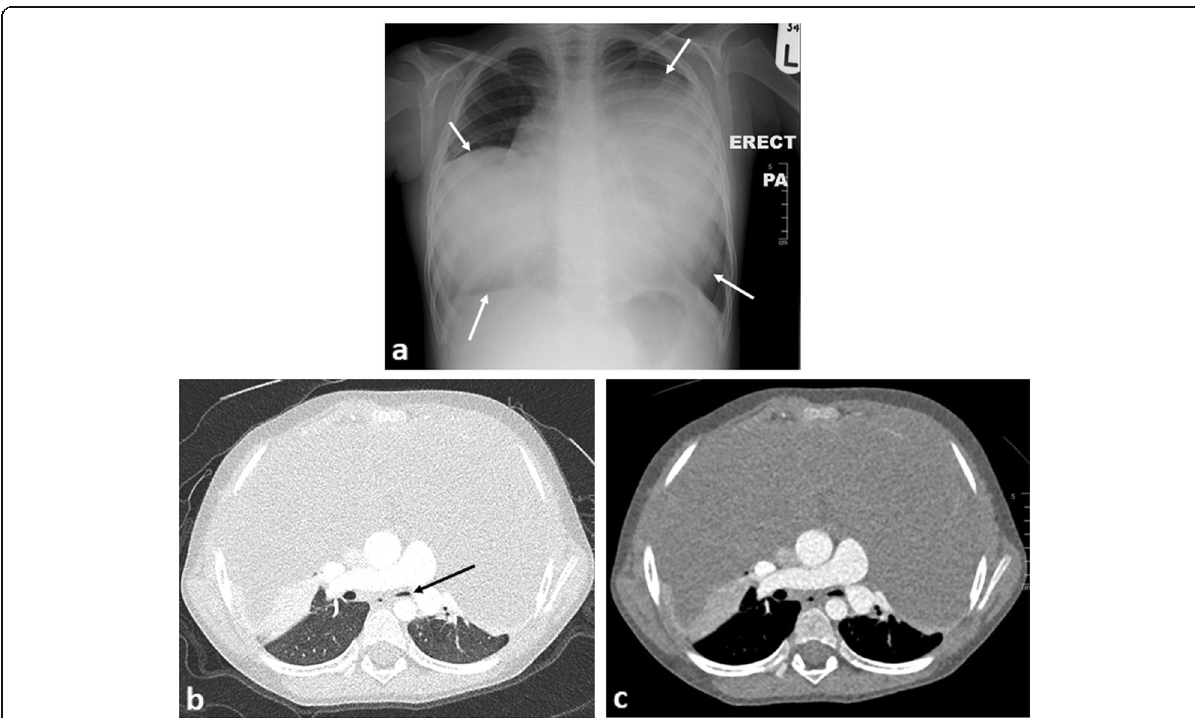
Fig. 8 A 4-year-old boy presenting with shortness of breath secondary to desmoid fibromatosis (a benign, non-cancerous tumour). a The erect chest radiograph demonstrates an enlarged anterior mediastinum with bilateral lobular mass-like appearances (arrows). b Axial contrast-enhanced CT of the chest (lung windows) demonstrates some compression of the left lower lobe bronchus (black arrow), with patency of the right lower lobe bronchus. c Axial CT image of the chest (mediastinal windows) demonstrates the homogenous nature of the anterior mediastinal mass (which would be unusual in a suspected teratoma). In contrast to the previous figure, this patient was able to lie flat in the scanner for their imaging study despite the seemingly larger sized mass on imaging. This demonstrates how imaging findings may not necessarily relate to the patient ’ s symptoms and careful assessment and history remain vital